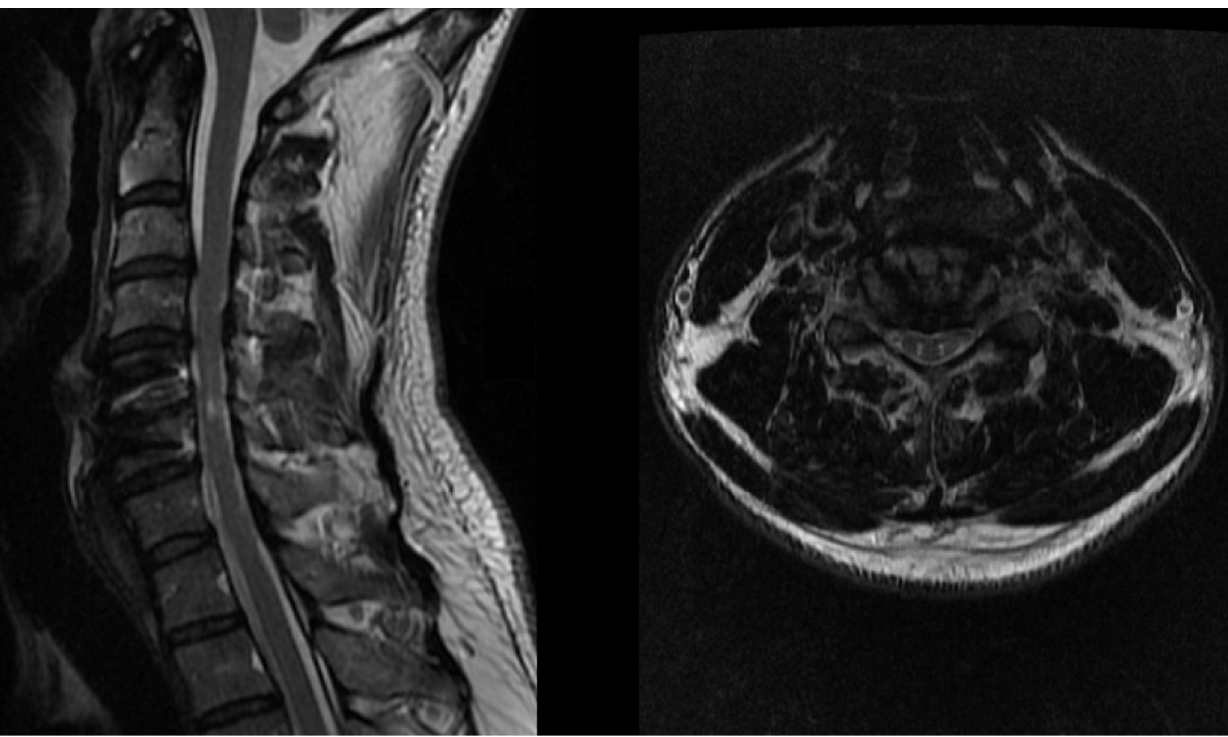
Figure 1. ‘Snake eyes appearance’ sign on MRI. Bilateral, circular symmetric foci can be observed within the grey matter on T2WI MRI, thought to represent cystic necrosis secondary to chronic compression and vascular insufficiency.